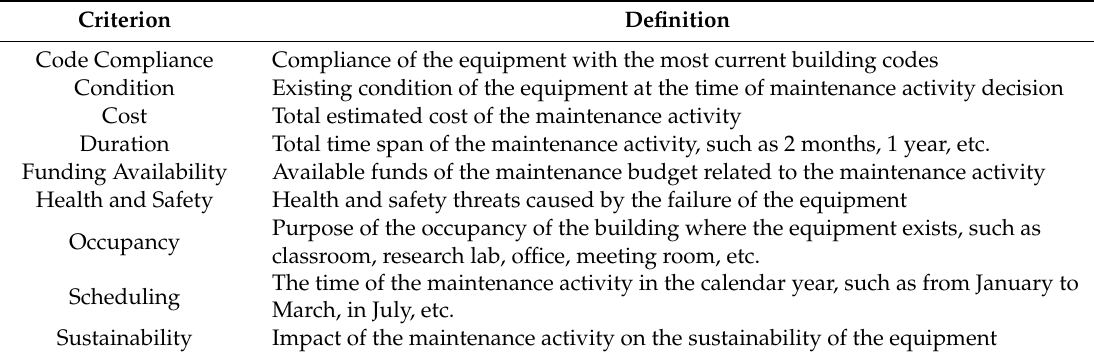
Table 2. Identified criteria for building maintenance decision-making through literature